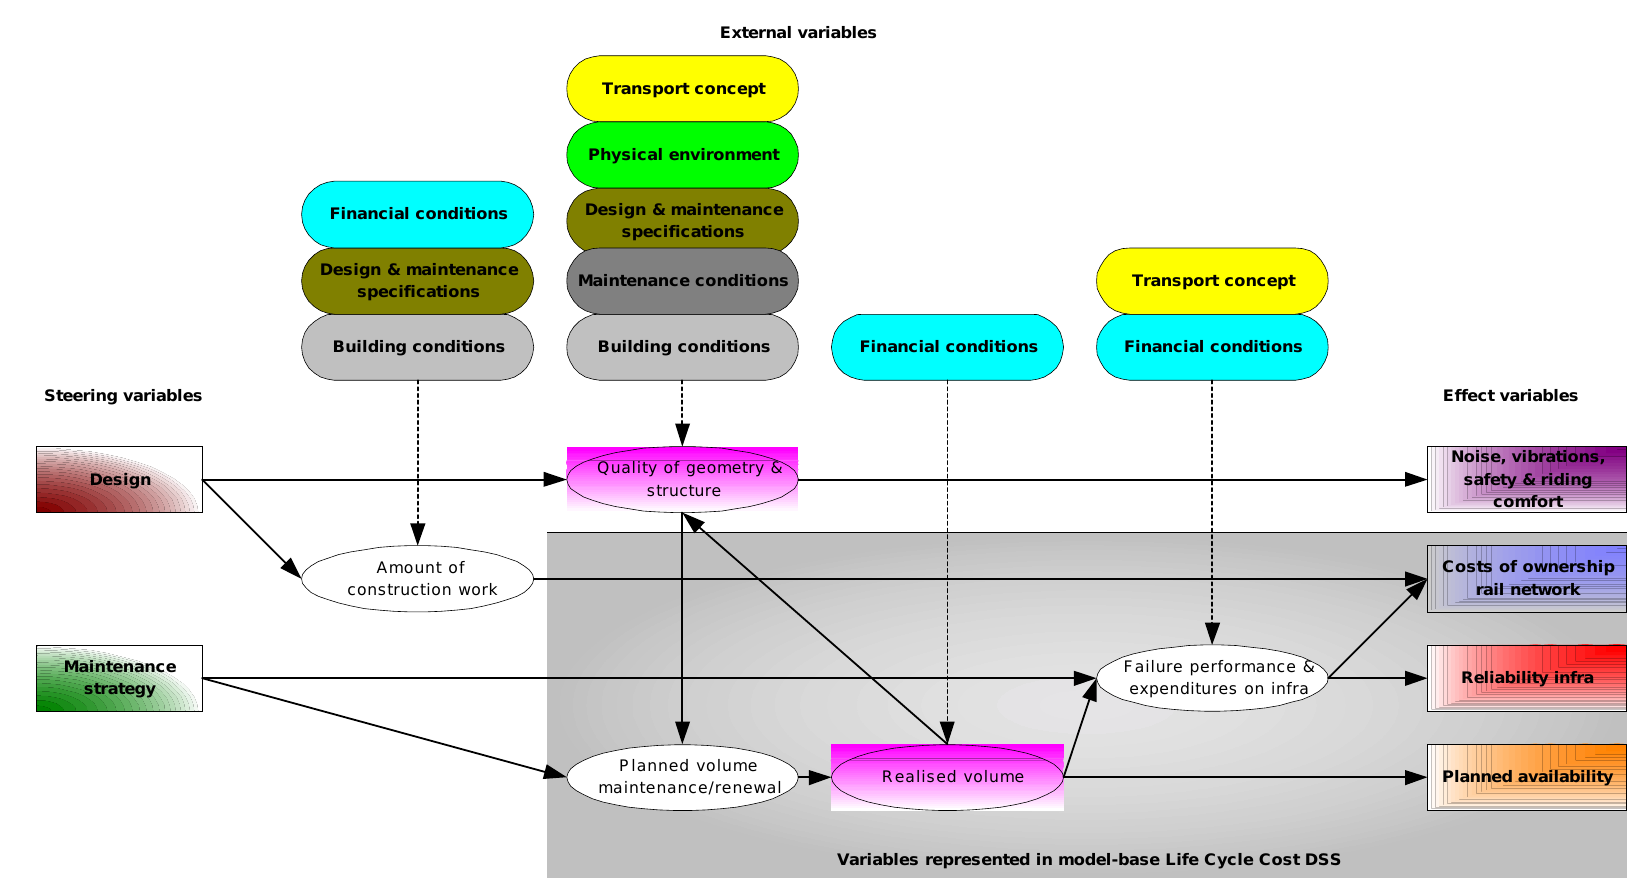
Figure 2. Factors influencing the performance of rail